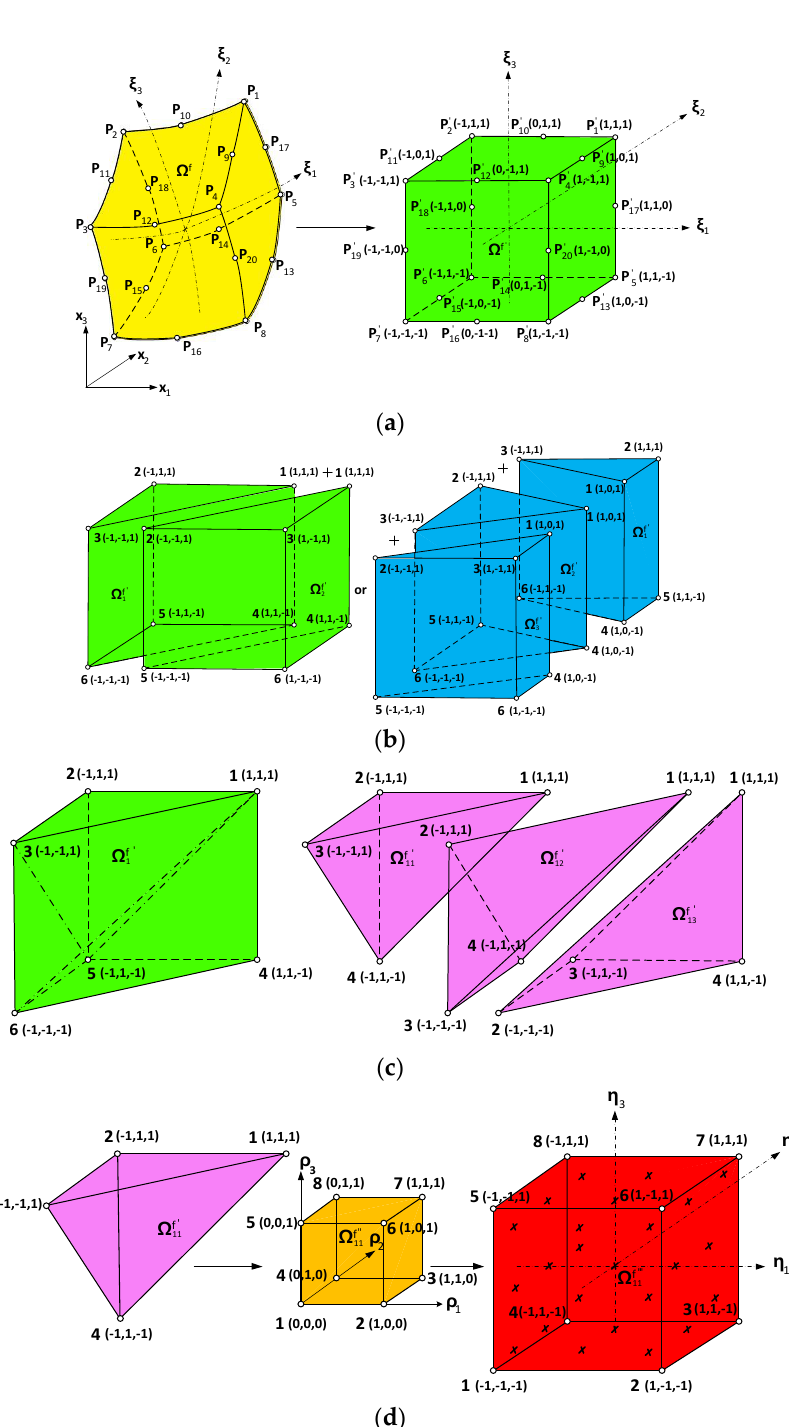
Figure 5. Application of the tetrahedron polar co-ordinates to quadratic, hexahedral, isoparametric singular elements [20]. ( a ) Mapping of Ω f onto Ω f ′ ; ( b ) subdivision of Ω f ′ at the singular point 1; ( c ) subdivision of triangular prism Ω 1f ′ into three tetrahedral; ( d ) mapping of Ω 11f ′ onto Ω 11f ′′ and of Ω 11f ′′ onto Ω 11f ′′′ .